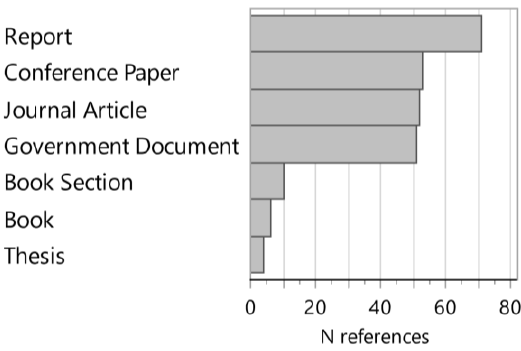
Figure 7. Reference types for papers that were selected for inclusion in Supplementary S5 and/or Supplementary S6.